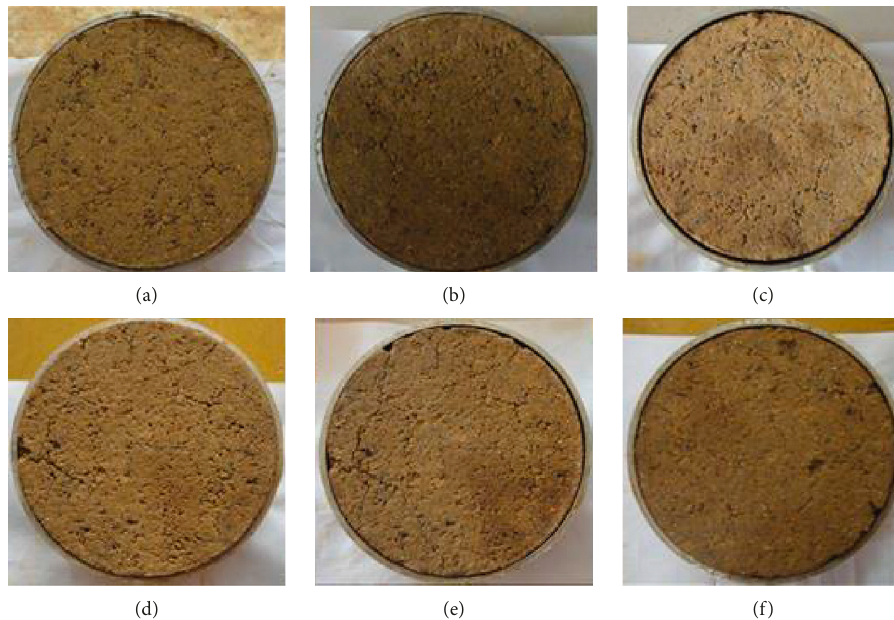
Figure 7: Photos of cracks on stabilized soil samples with different numbers of drying-wetting cycles. (a) 1 cycle. (b) 7 cycles. (c) 13 cycles. (d) 19 cycles. (e) 25 cycles. (f) 31 cycles.